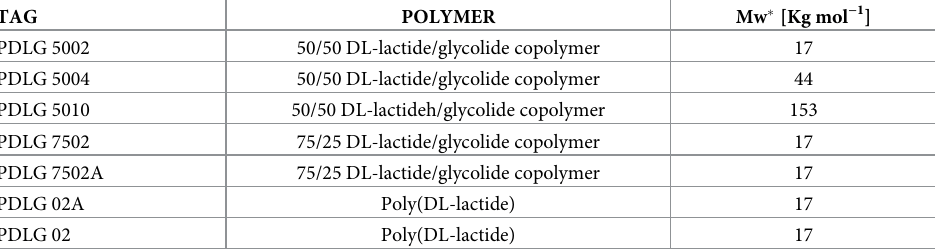
Table 1. PDLA polymers tested and modelled in this study. The tag, proportion of DL-lactide and glycolide, and molecular weight are provided. The symbol (cid:3) means that is relative to polystyrene standards (indicative values based on a Mark Houwink type